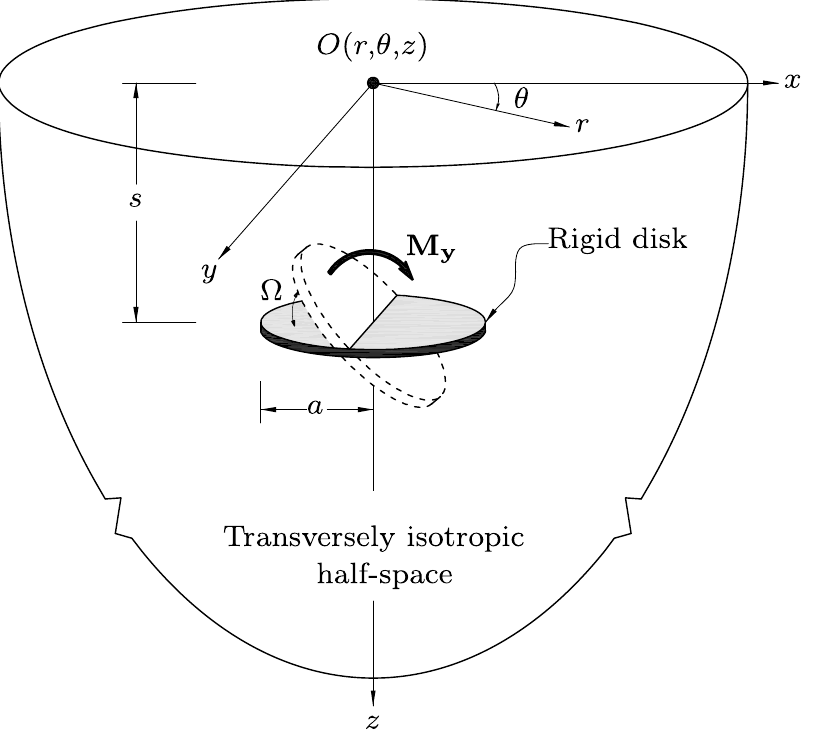
Fig. 1. Rocking rotation of a rigid disk embedded in a finite depth of a transversely isotropic